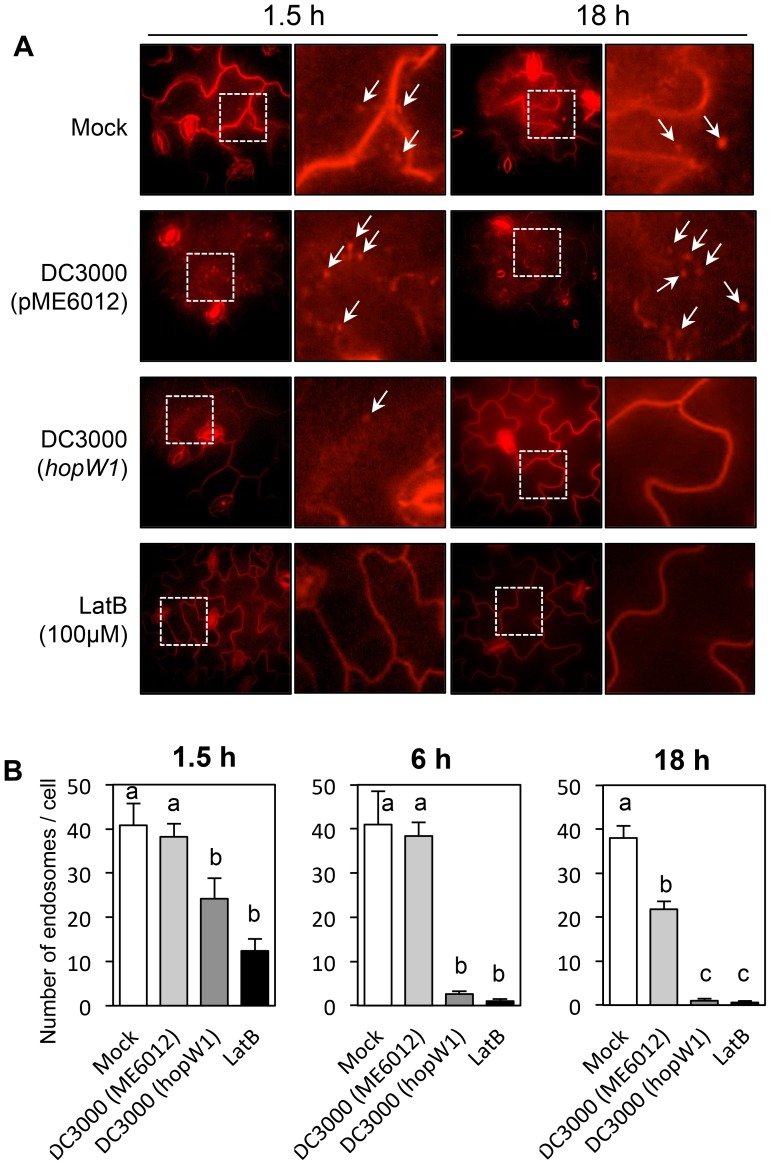

PtoDC3000/HopW1 infection inhibits endocytosis.(A) Examples of microscopic images of infected tissue in which endosomes are visualized using FM4-64. Cotyledons of Arabidopsis Col seedlings grown on MS plates were infected with PtoDC3000 carrying either empty vector (pME6012) or vector with the HopW1 gene at OD600 = 0.01. 100 µM LatB was used as an actin cytoskeleton-disrupting control. After infections and treatments for the indicated times, cotyledons were labeled for 1 h with FM4-64 and viewed. Arrows indicate some of the FM4-64-labeled endosomes. (B) Quantitation of the data in (A). Endosomes per cell were manually counted in at least 10 images per treatment, per time-point, from two or three biological repeats. Bars indicate SEM. Different letters indicate significantly different numbers of endosomes for given treatments, as determined by ANOVA/Tukey's test (P<0.05).